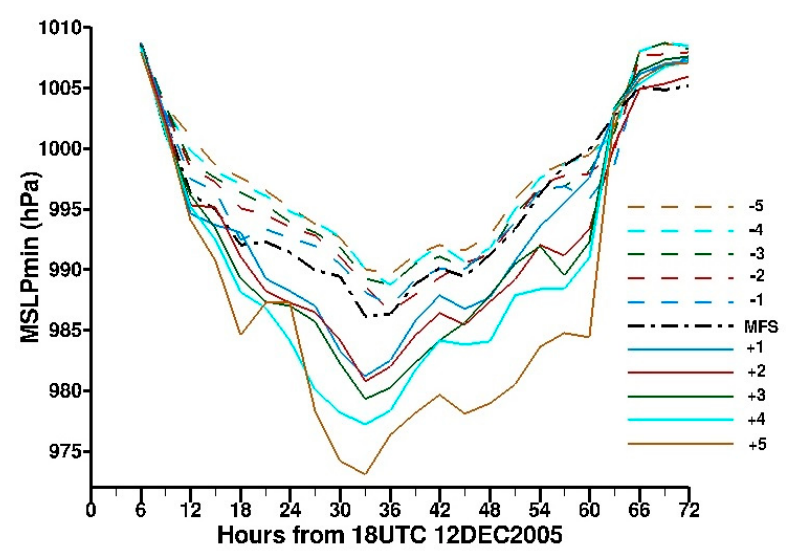
Figure 17. Time series of the minimum MSLP (hPa) for the MFS run (black) and the 10 SST anomaly experiments (solid lines for warmer SSTs and dashed lines for cooler SSTs).